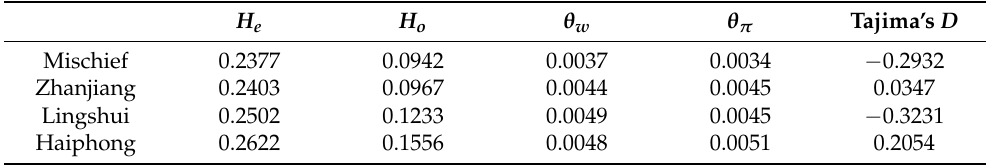
Table 1. Population genetic parameters of the four